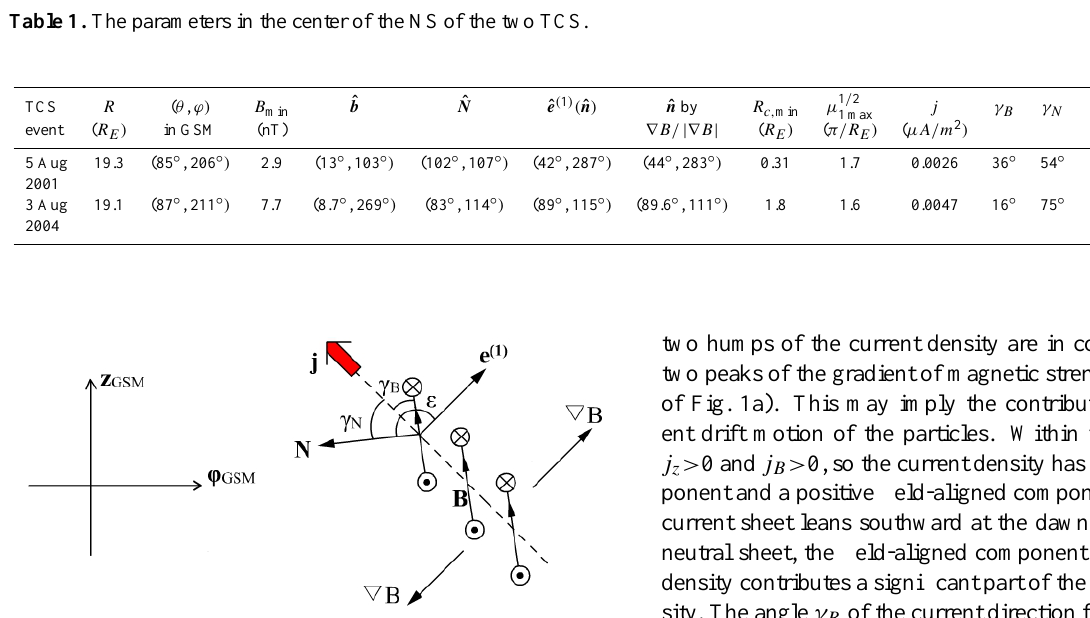
field direction decreases to γ B ≈ 36 . 8 ◦ (< 90 ◦ ) at the center of Fig. 2. Schematic illustration of the geometrical structure of the the neutral sheet. The angle γ N between the current density tilted current sheet during the Cluster crossing event on 5 August Schematic illustration of the geometrical structure of the tilted current and the binormal ˆ N is rather stable in the neutral sheet, and 2001 viewed toward the earth. The dashed line denotes the central γ N ≈ 54 ◦ at the center. The angle ε between the first e ( 1 ) and plane of the current sheet. The red arrow represents the current sheet during the Cluster crossing event on 5 Aug 2001 viewed toward the earth. The the binormal ˆ N of the MFLs varies as Cluster crosses the cur- density. The directions of the magnetic field in the MFLs have been